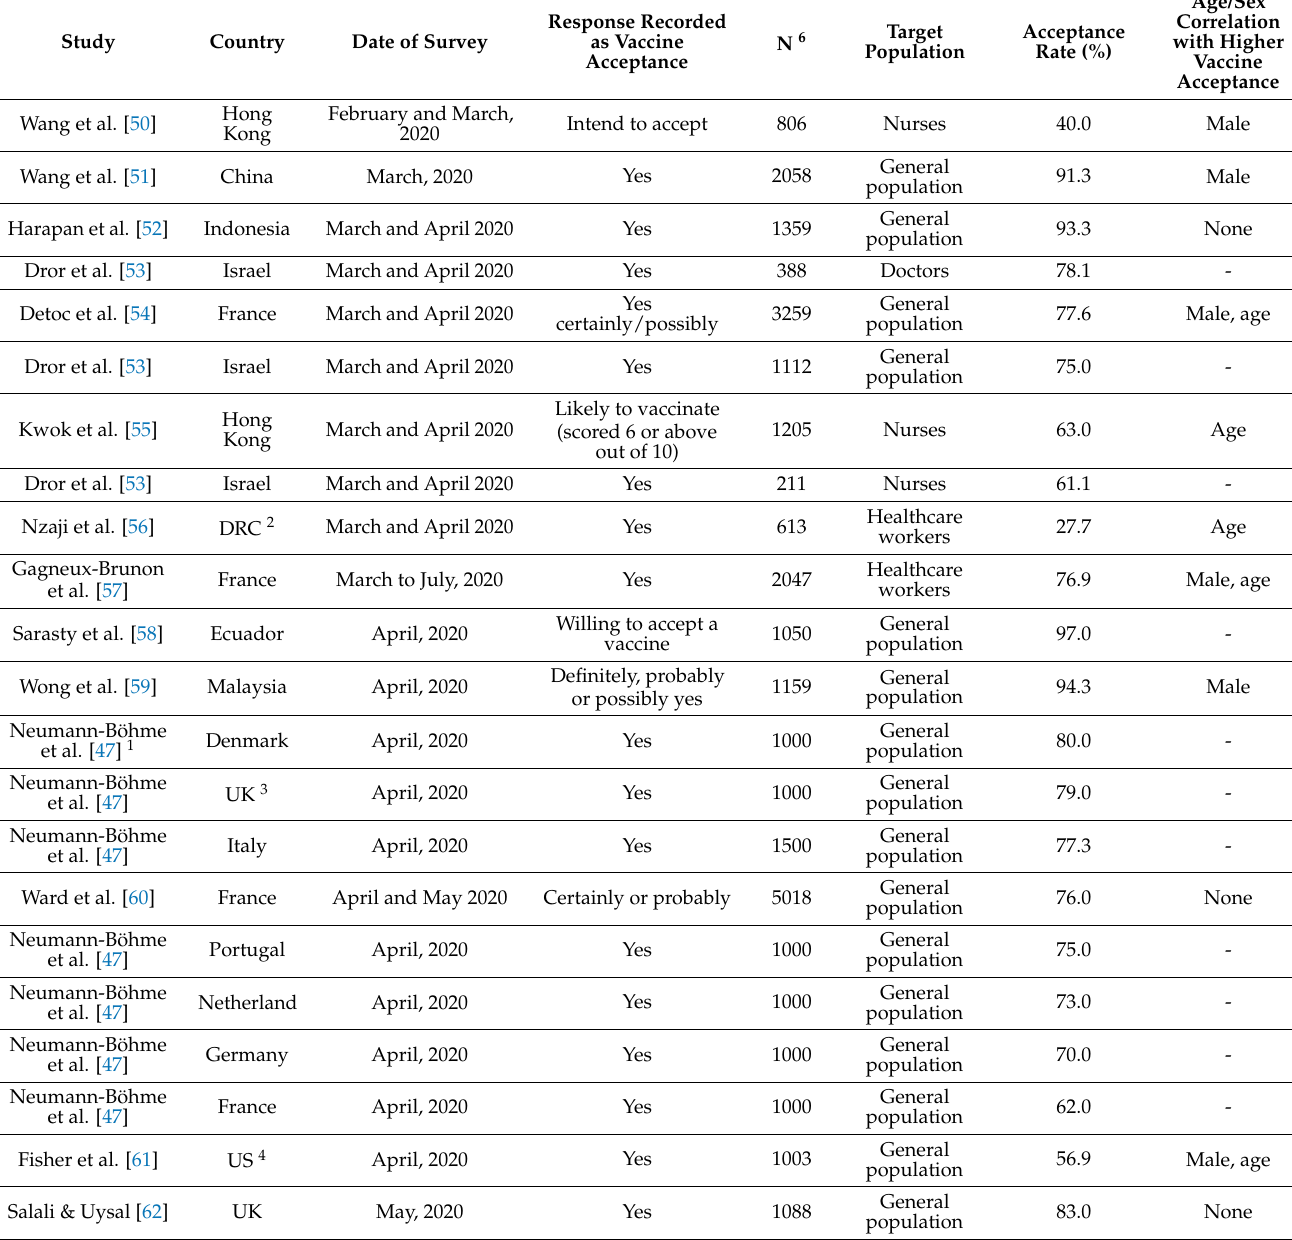
Table 1. COVID-19 acceptance rates divided by the included studies and sorted based on the date of